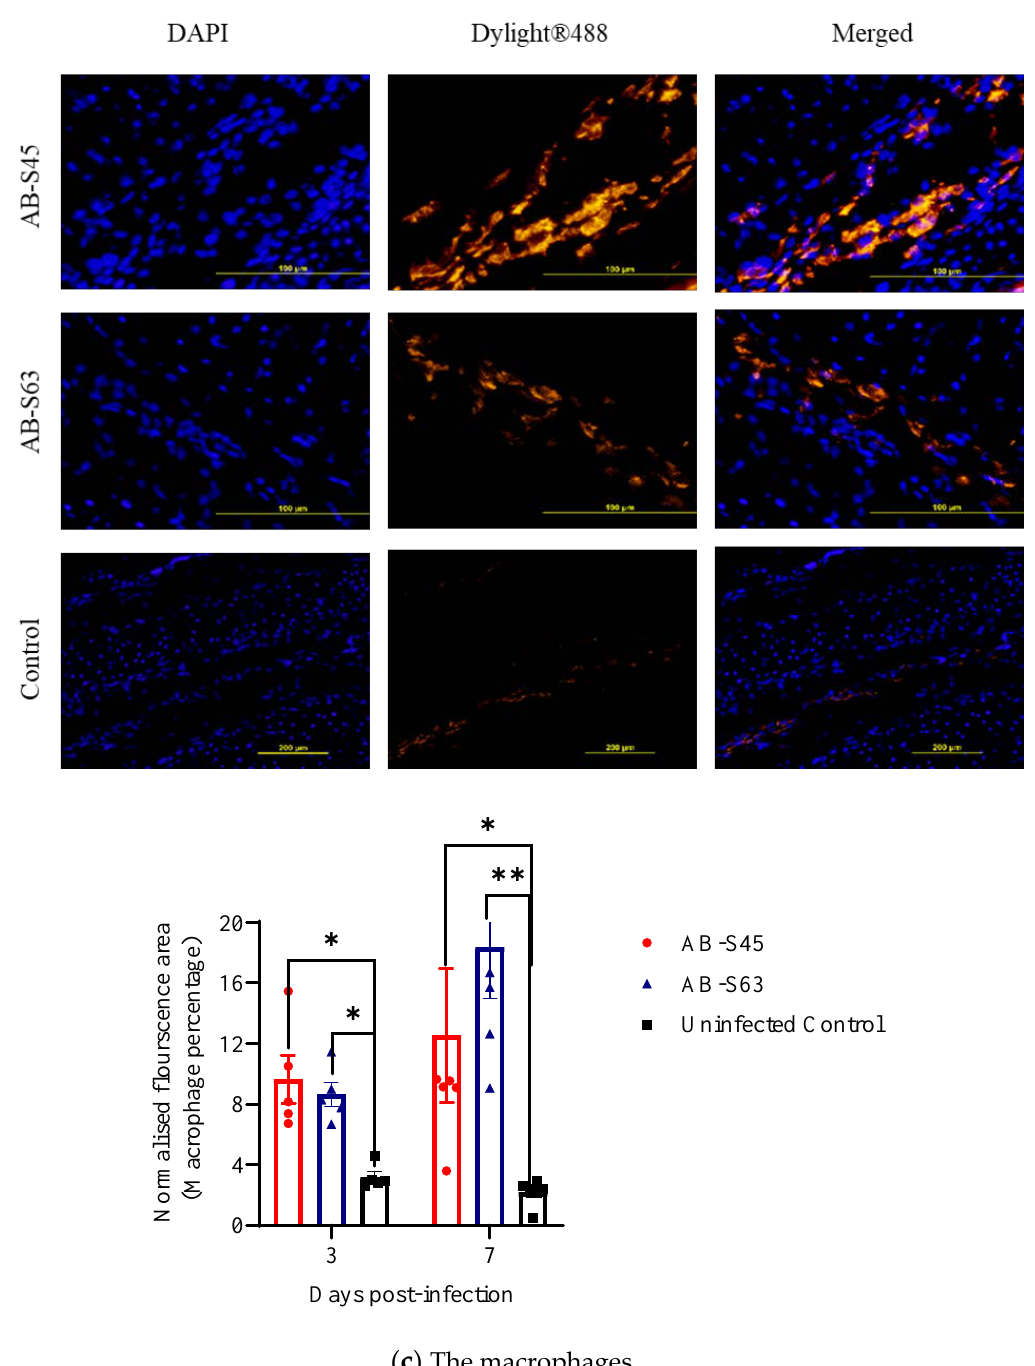
Figure 3. The immune cell recruitment in infected and control trachea following infection with wildtype (AB-S63) and CEO vaccine revertant (AB-S45) ILTV isolates and mock infection with PBS. The representative images show ( a ) CD4+ T cells, ( b ) CD8+ T cells, and ( c ) macrophages present in the trachea of the infected and uninfected chickens along with quantitative data. The Mann–Whitney U test was employed to compare infected and uninfected groups at 3 and 7 dpi. The error bars indicate the SEM. Significance: * p < 0.05, ** p < 0.01.